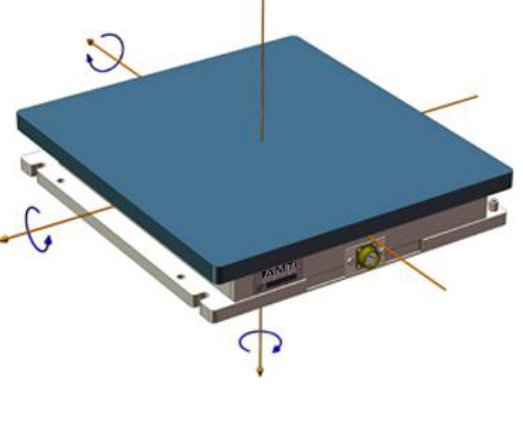
Figure 5. Example of AMTI Force Plate showing the three forces and the three moment components along the three measurable GFR axis. Reproduced with permission from